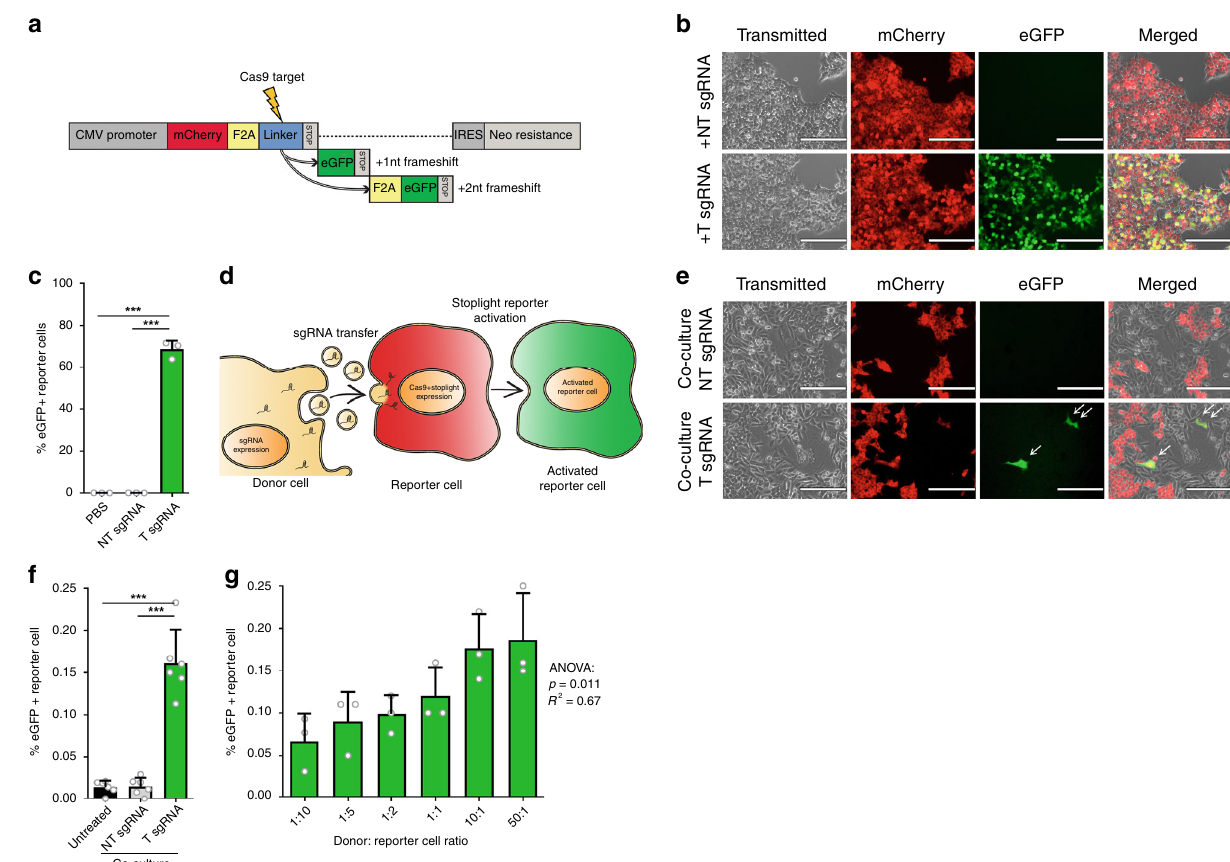
Fig. 1 Establishment of a CRISPR/Cas9-activated fl uorescence reporter platform to study EV-mediated RNA transfer. a Schematic showing the CRISPR/Cas9-activated fl uorescent stoplight reporter system. mCherry is expressed under a CMV promoter, followed by a Cas9-targeted linker region and a stop codon. Two eGFP open reading frames are placed after the stop codon, one or two nucleotides (nt) out of frame, respectively. Upon a Cas9- mediated frameshift in the linker region, either one of these eGFP open reading frames will be permanently expressed alongside mCherry. F2A self-cleaving peptide domains are placed between each fl uorescent protein. b Fluorescent microscopy images of stable HEK293T Stoplight + spCas9 + cells after transfection of a plasmid encoding a sgRNA targeting the linker region of the Stoplight construct ( + T sgRNA, bottom row), or a non-targeting sgRNA ( + NT sgRNA, top row). Scale bar represents 200 µ m. Representative images as observed in three independent experiments. c Flow cytometry analysis of stable HEK293T Stoplight + spCas9 + cells after addition of PBS, transfection of a non-targeting sgRNA (NT sgRNA), or a sgRNA targeting the Stoplight construct (T sgRNA). Means + SD, n = 3 independent experiments, Student ’ s t -test. d Cartoon explaining the CROSS-FIRE system. Donor cells (yellow cell, left) express sgRNAs targeting a stoplight construct, which is expressed alongside Cas9 in reporter cells (red cell, middle). Upon functional transfer of sgRNAs from the donor cells to the reporter cell, Cas9 and sgRNA will together activate the stoplight construct in the reporter cell, resulting in permanent eGFP expression (green cell, right), which may then be quanti fi ed by fl uorescence microscopy or fl ow cytometry. e , f A fi ve day co-culture of HEK293T Stoplight + spCas9 + reporter cells with MDA-MB-231 sgRNA + donor cells expressing a targeting sgRNA (T sgRNA), or a non-targeting sgRNA (NT sgRNA), analyzed by fl uorescence microscopy ( e ) and fl ow cytometry ( f ). Scale bar represents 200 µ m. Representative images as observed in six independent experiments Means + SD, n = 6 independent experiments, Tukey ’ s multiple comparison test. g Quanti fi cation of a fi ve day co-culture of HEK293T Stoplight + spCas9 + reporter cells with MDA-MB-231 sgRNA + donor cells in varying donor cell: reporter cell ratios by fl ow cytometry. Means + SD, n = 3 independent experiments, ANOVA. *** p